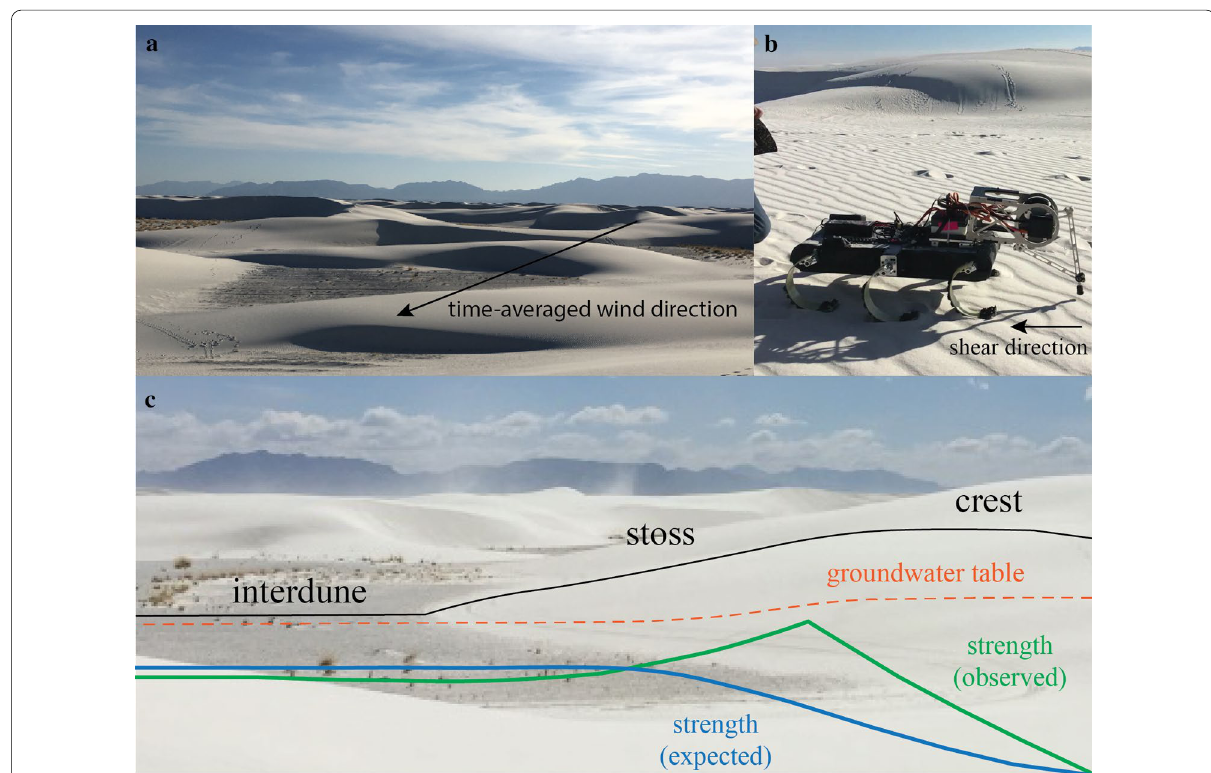
Fig. 2 a Sample field site in White Sands, NM where geoscientists used the robot RHex (Qian et al., 2017) to measure surface-soil shear strength (inversely related to and hence a proxy for erodibility) along dunes with sharp moisture gradients. b For each shear test, the leg penetrated a few millimeters into the sand, and then dragged a thin layer of grains across the surface while measuring the mechanical shear strength of the sand. See Additional file 1 for a video of RHex performing the shear test. c Transect (black line) of a dune where measurement data were collected (picture from Qian et al., 2019). At the crest of the dune, where soil was driest because of its distance from the groundwater table (orange line), shear strength was expected to be low. As moisture increased on the stoss face moving towards the interdune, shear strength was expected to also increase before leveling off at the point of moisture saturation. This pattern of expected results is displayed in blue. Instead, geoscientists observed that shear strength decreased slightly as soil became more saturated nearing the interdune area just before levelling off (green